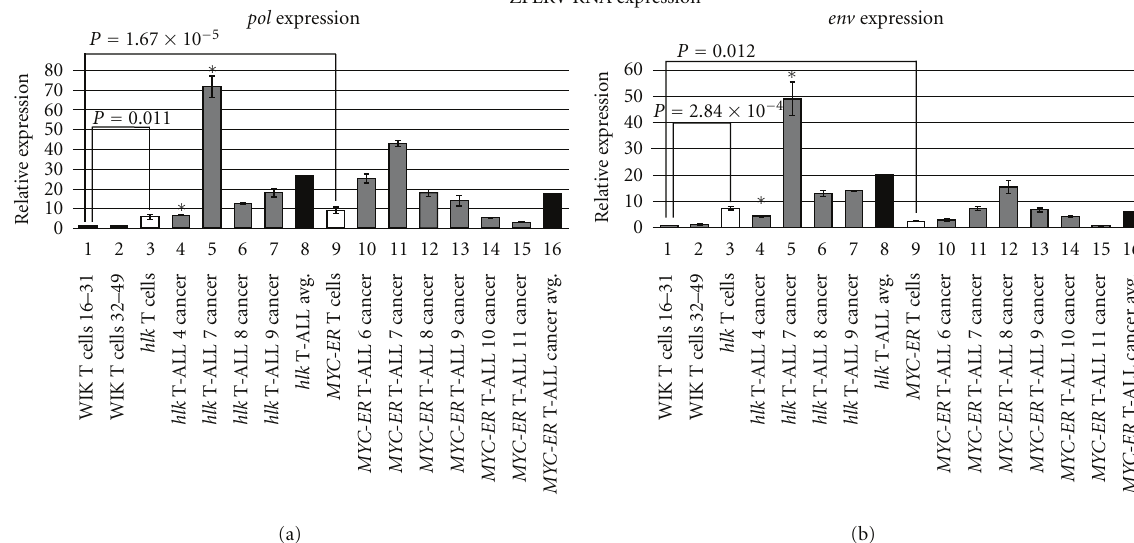
Figure 7: ZFERV gene expression by normal and abnormal D. rerio T cells. Total RNA was tested by qRT-PCR of the ZFERV pol (a) and env (b) genes. Normal T cell RNA pooled from WIK fish ( n = 16 and 18; lanes 1, 2) were used as control, and the “WIK T cells 16–31” sample was arbitrarily set to an expression value = 1. Premalignant T lymphocytes from hlk ( n = 6) and MYC-ER ( n = 3) fish had higher expression than WT fish (white bars; lanes 3, 9), and this higher transcription reached statistical significance. Individual cancers from hlk ( n = 4; lanes 4–7) and MYC-ER ( n = 6; lanes 10–15) fish are depicted with gray bars. Cancer cells from these fish invariably showed higher pol and env transcripts than T cells from WT fish, and nearly always had elevated RNA expression relative to normal T cells from these same two lines. Mean expression of pol and env in malignant T cells (black bars; lanes 8, 16) exceeded both WT and premalignant T cell transcript levels. Two cancers highlighted by asterisks ( hlk T-ALL 4, hlk T-ALL 7; lanes 4, 5) were also tested for genomic copy number by qPCR. The hlk T-ALL 4 cancer had ZFERV copy number similar to hlk premalignant T cells (see Figure 4), and its pol and env expression also resembled hlk T cells. Cells from the hlk T-ALL 7 sample had high-level genomic ZFERV gains (see Figure 6), and likewise demonstrated dramatically increased ZFERV